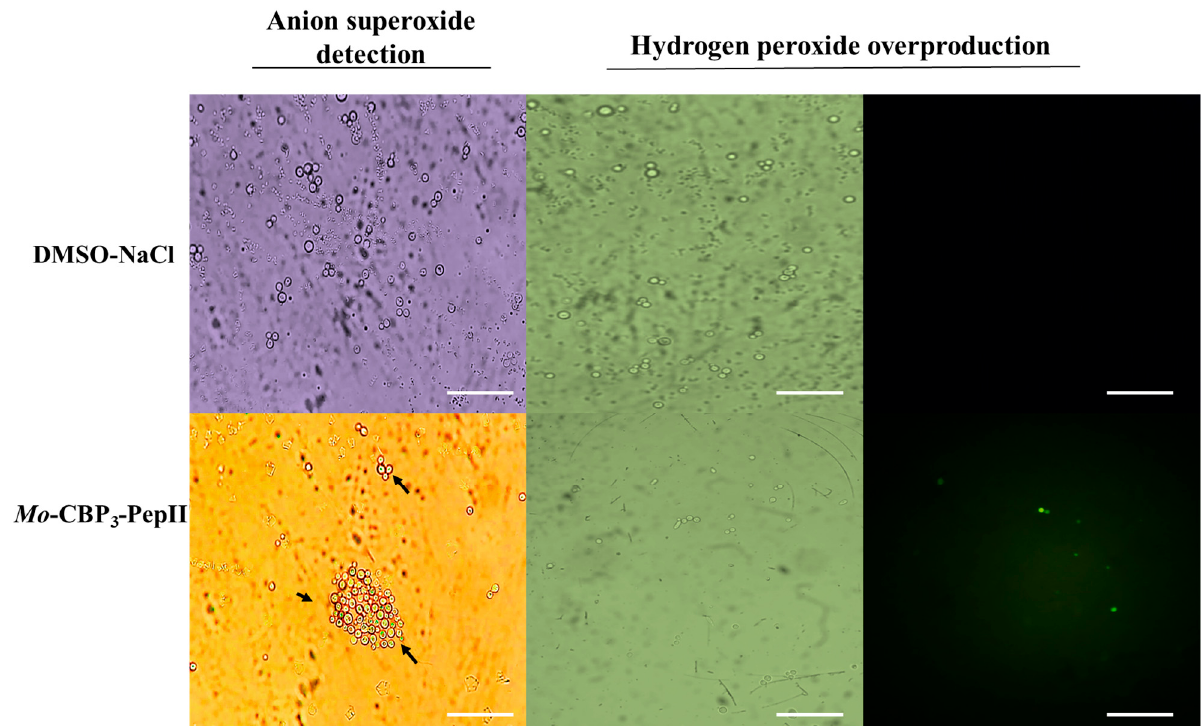
Figure 1. Detection of anion superoxide and hydrogen peroxide in C. neoformans cells. Light and fluorescence microscopies analysis to detect, respectively, the conversion of NBT (nitro blue tetrazolium chloride) into formazan (blue or cyan dots—black arrows) and the accumulation of hydrogen peroxide in C. neoformans cells treated with Mo -CBP 3 -PepII at MIC 50 concentration. White bars indicate 100 µm.